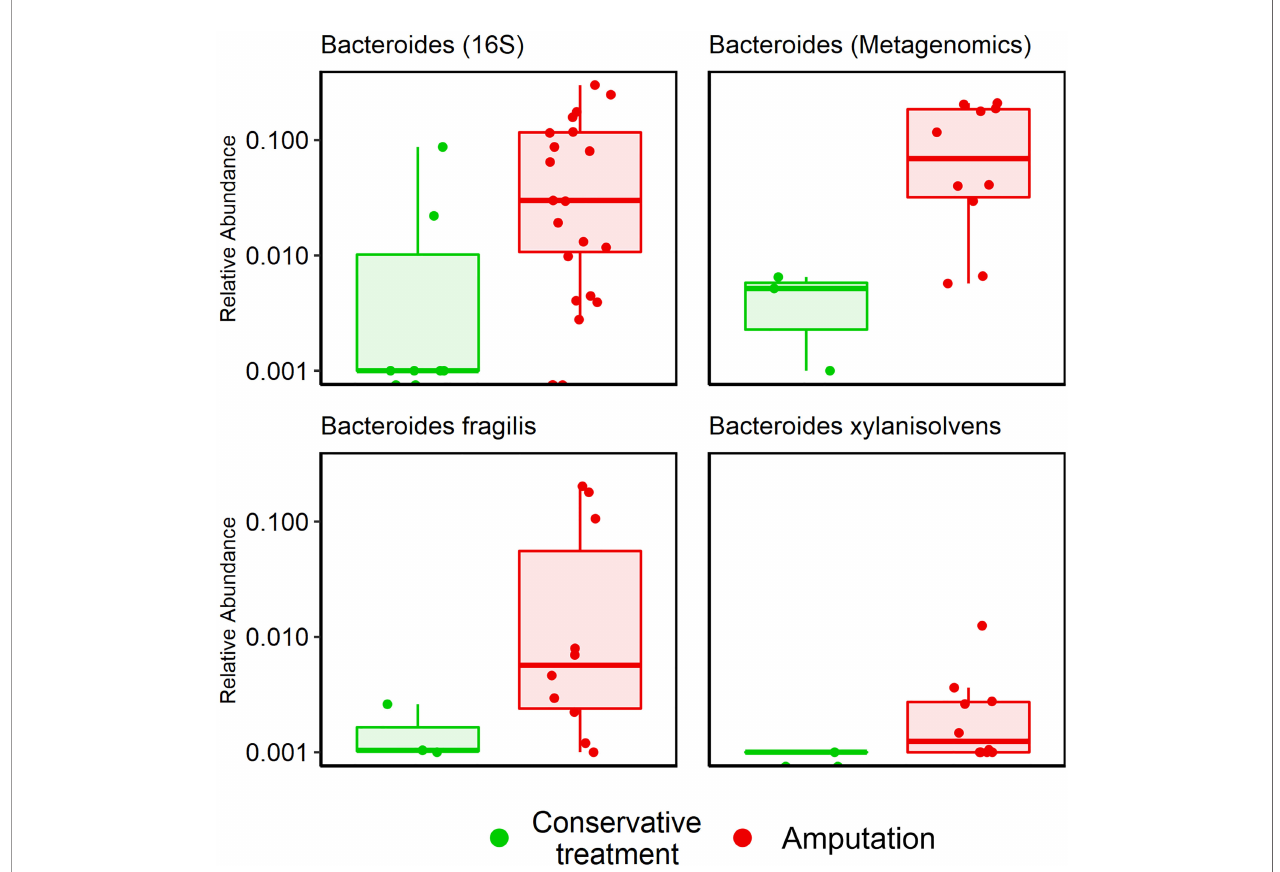
FIGURE 4 | Association between Bacteroides genus and amputation according to 16S rRNA sequencing and metagenomic sequencing. Bacteroides genus, p<0.001 ; Bacteroides fragilis , p=0.04; Bacteroides xylanisolvens , p=0.002.